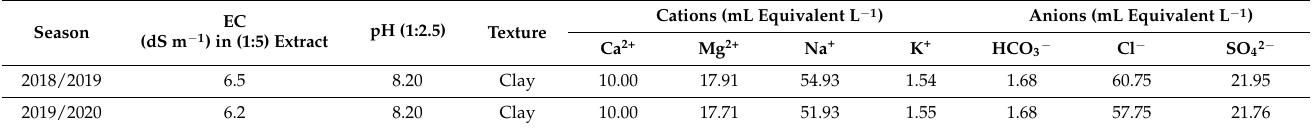
Table 1. The soil physical and chemical properties of the experimental site in seasons 2018/2019 and 2019/2020.